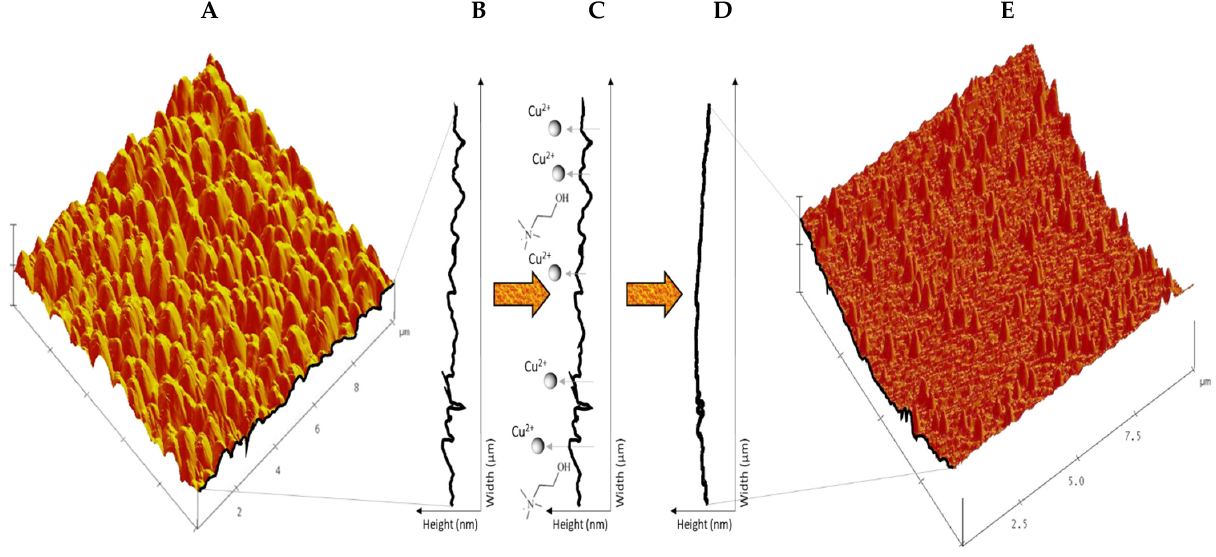
Figure 1. Schematic diagram of anodic leveling of high-purity copper surfaces via AFM at different phases of the study: ( A ) before electropolishing, and ( E ) after electropolishing treatments with the deep eutectic solvent, with representative 2D surface profiles depicted ( B ) before, ( C ) during and ( D ) after experiments. Presence of ( CH 3 ) NCH 2 CH 2 OH, the choline chloride radical, and Cu 2+ are 3 abbreviated in ( C ). AFM Z -axis = 100